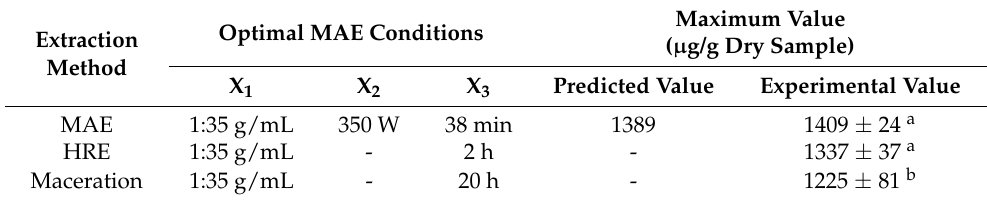
Table 4. Predicted value, experiment confirmation of the optimal MAE condition, and comparison of MAE with conventional extraction